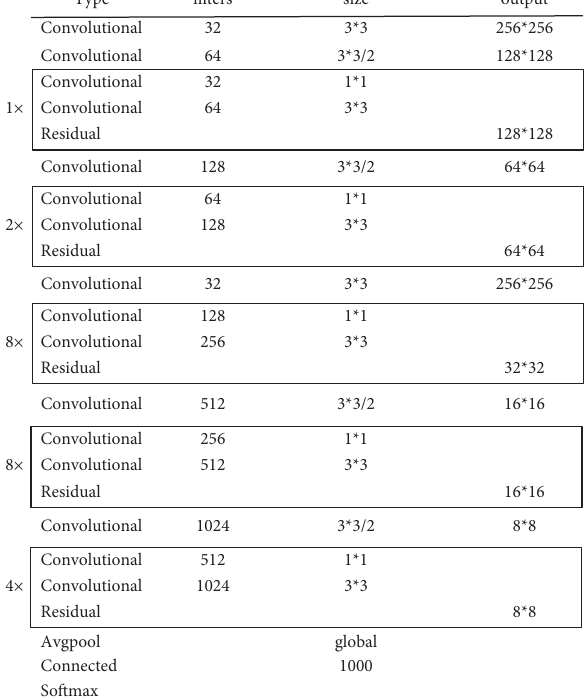
Figure 1: Network structure of YOLOv3